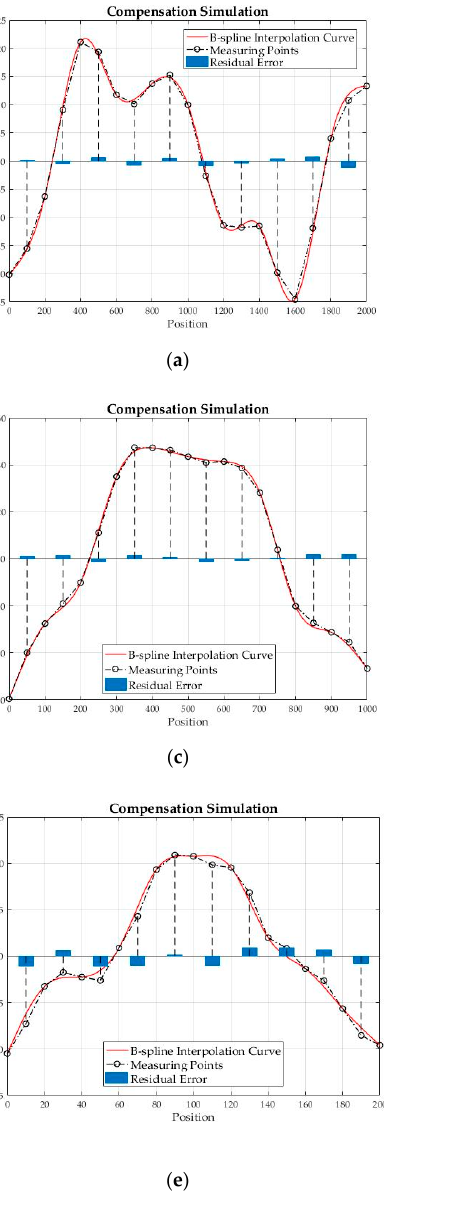
Figure 7. Compensation simulation with B-spline interpolation model. ( a ) Y-direction straightness error in X-direction movement; ( b ) Z-direction straightness error in X-direction movement; ( c ) X-direction straightness error in Y-direction movement; ( d ) Z-direction straightness error in Y-direction movement; ( e ) X-direction straightness error in Z-direction movement; ( f ) Y-direction straightness error in Z-direction movement.